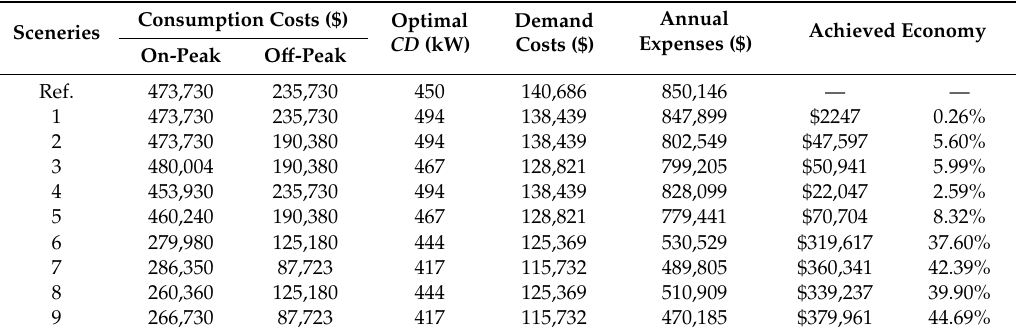
Table 14. Annual Energy Consumption and Power Demand expenses for each